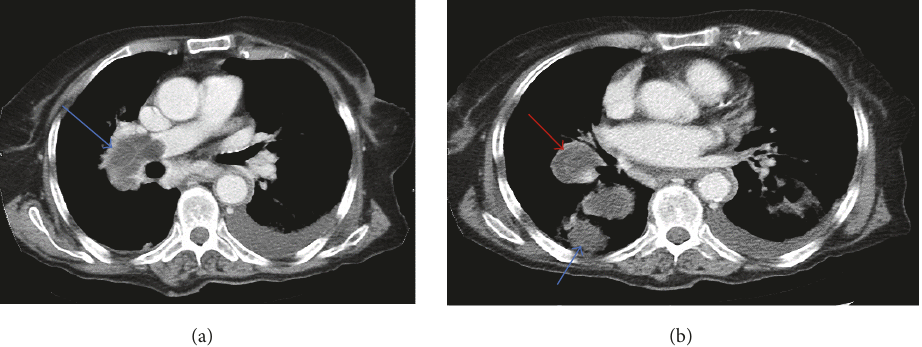
Figure 1: (a-b) CT axial images show pulmonary artery with multiseptate hydatid cysts (red arrows), seen in the right main pulmonary artery and the lower lobar branches of the right pulmonary artery, along with other parenchymal cysts (blue arrows).